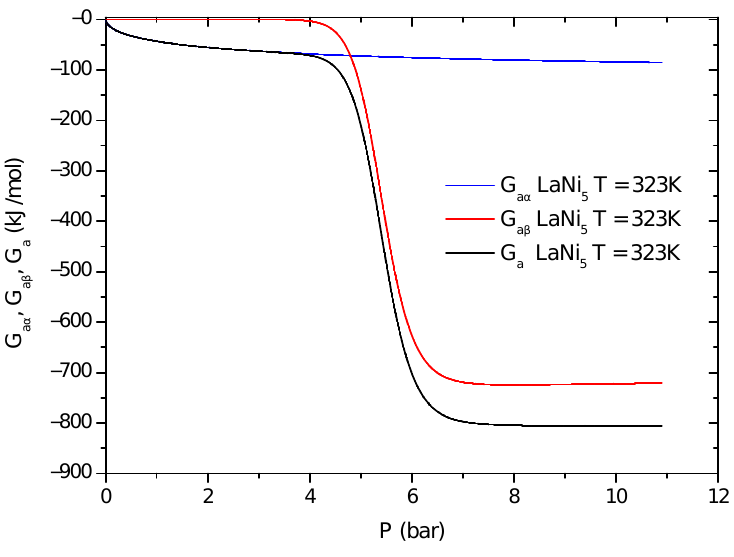
Figure 9. Evolution of the Gibbs free energy G a of the first (Equation (25)) and second sites (Equation (26)), and the overall G a (Equation (24)) versus pressure for LaNi 5 at T = 323 K. The Gibbs free energy values in the high pressure range are negative. Hence, ab- sorption phenomena are spontaneous in their nature. At a fixed pressure and increasing temperature, the values of total G a increase algebraically and decrease in absolute value.